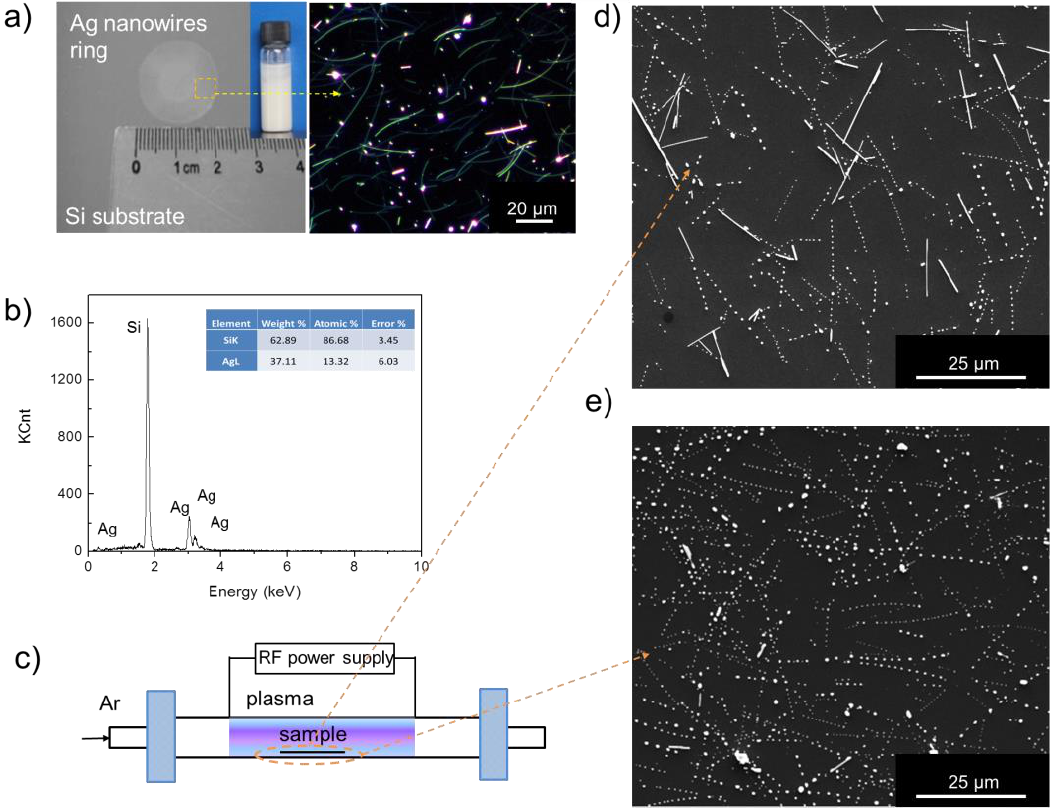
Figure 1. ( a ), “Coffee ring” and optical image of hydrothermal synthesized Ag nanowires (AgNWs) on silicon surface; inset image is the AgNWs ethanol suspension with 0.5 wt%; ( b ), element analysis on sample (Figure 1e) with energy dispersive spectrometer; ( c )–( e ) the radio frequency (RF) plasma device and morphologies of AgNWs treated by RF plasma for 3 min and 5 min.